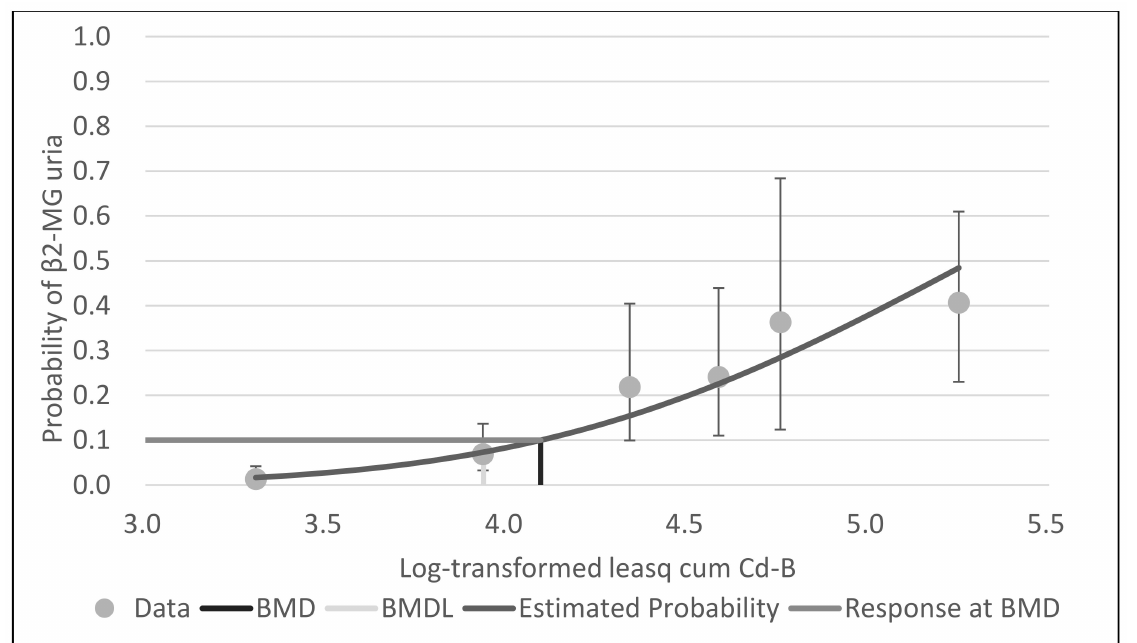
Figure 3. Probit model with BMR of 10% extra risk for the BMD and 95% lower confidence limit for the BMDL of log-transformed leasq cum Cd-B for β 2-MG uria.